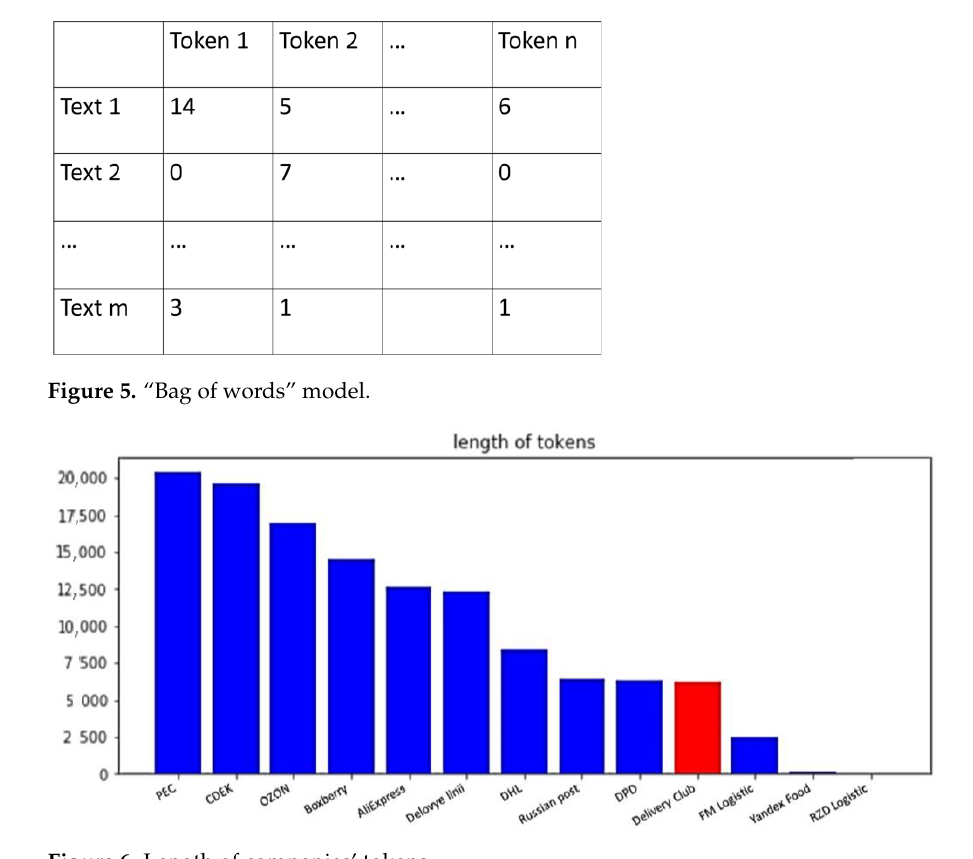
Figure 6. Length of companies’ tokens .